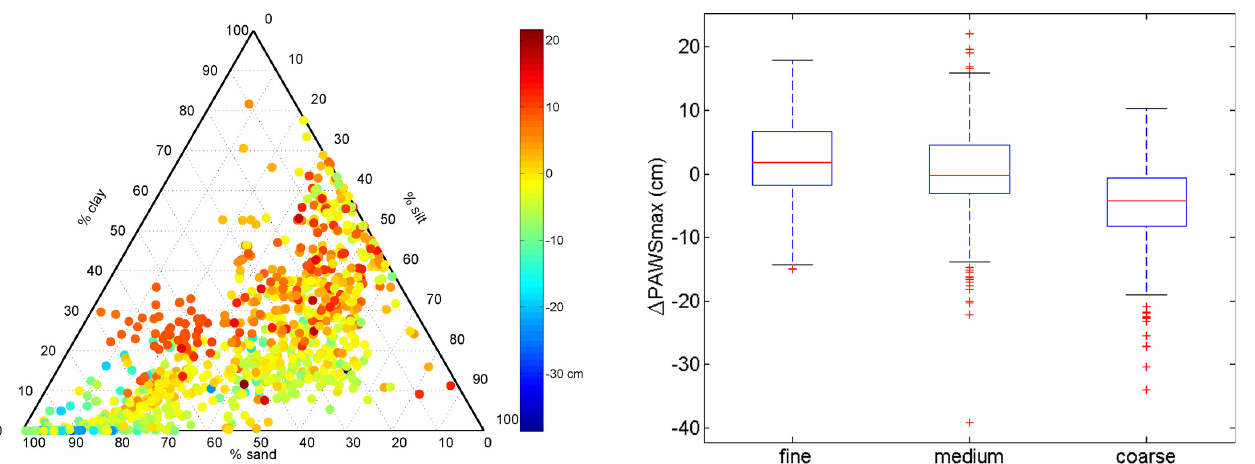
Fig. 6. Boxplots of variable 1 PAWS max for the soils of the fine, medium, and coarse soil texture classification according to the FAO-